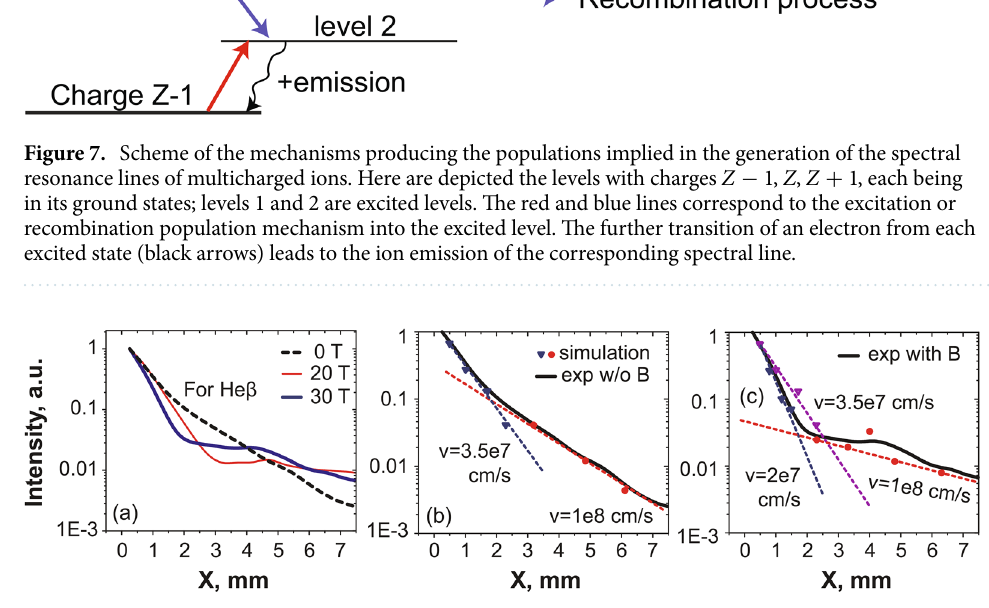
Figure 8. ( a ) Relative intensity of the spectral line He β measured by the FSSR spectrometer in the experiment both for a free expansion (black) and for the propagation in the transverse magnetic field with a strength of 20 (red) and 30 T (blue). ( b ) Experimental and simulated intensity profiles for the resonance line He β in the free expansion case. Theoretical intensities were normalized by the corresponding experimental point. The inferred plasma parameters are indicated. ( c ) Same as ( b ) but for the case when the transverse magnetic field B is applied. Our analysis suggests an electron temperature of 54 eV at a density of 2